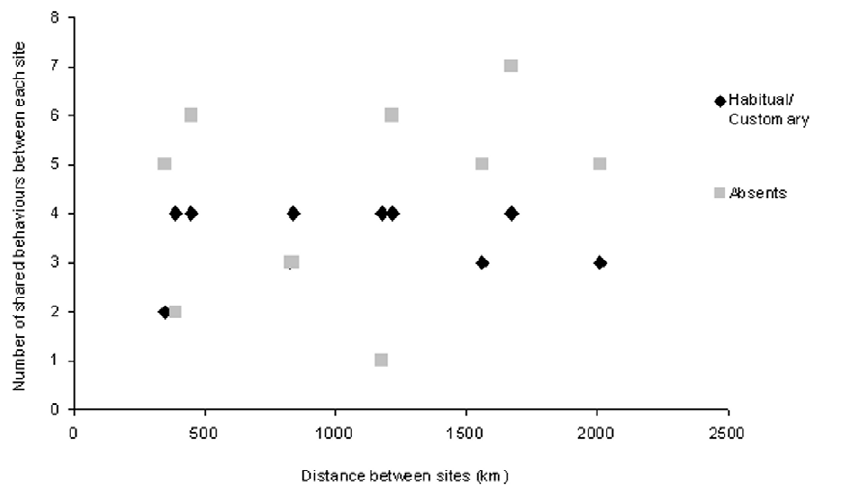
Figure 4. Association between the number of customary/habitual behaviors or absence of behavior each pair of study sites shared and the distance between each pair of sites.